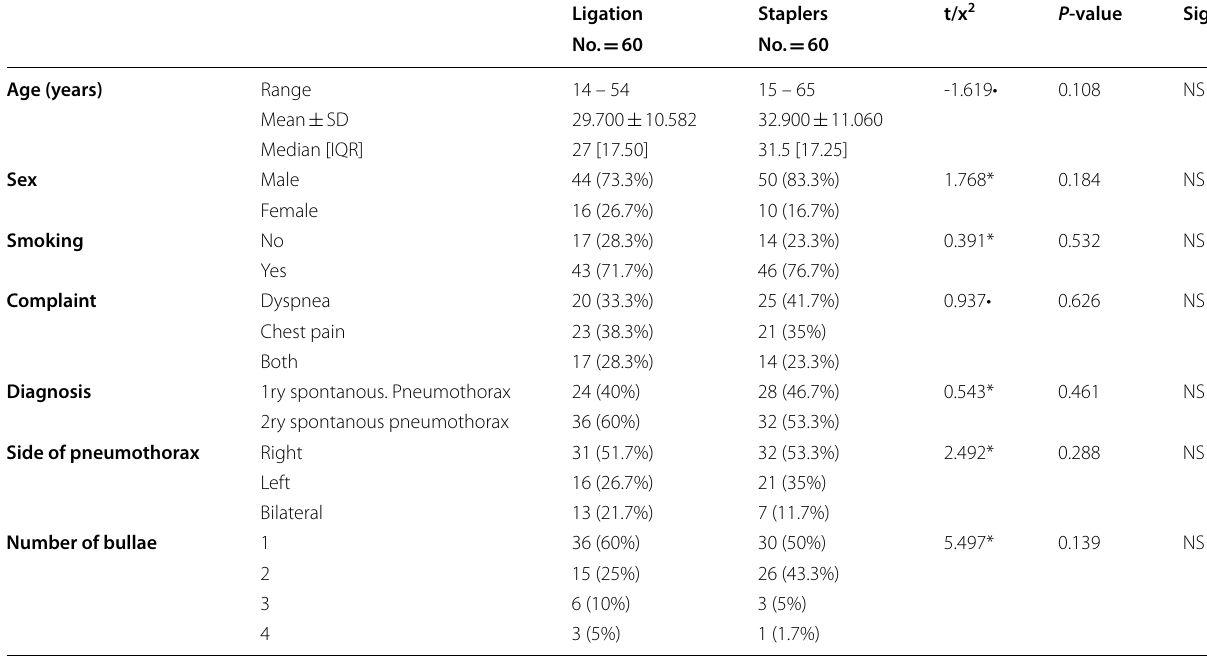
P -value > 0.05: Non-significant, P -value < 0.05, Significant, P -value < 0.01: highly significant *